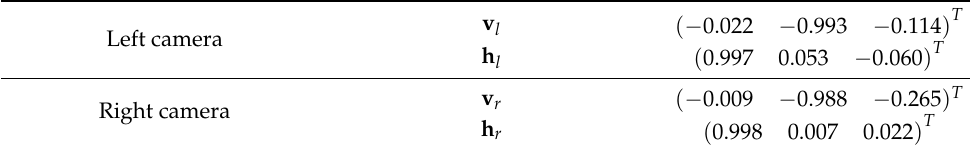
Table 2. Rotation vectors of left and right